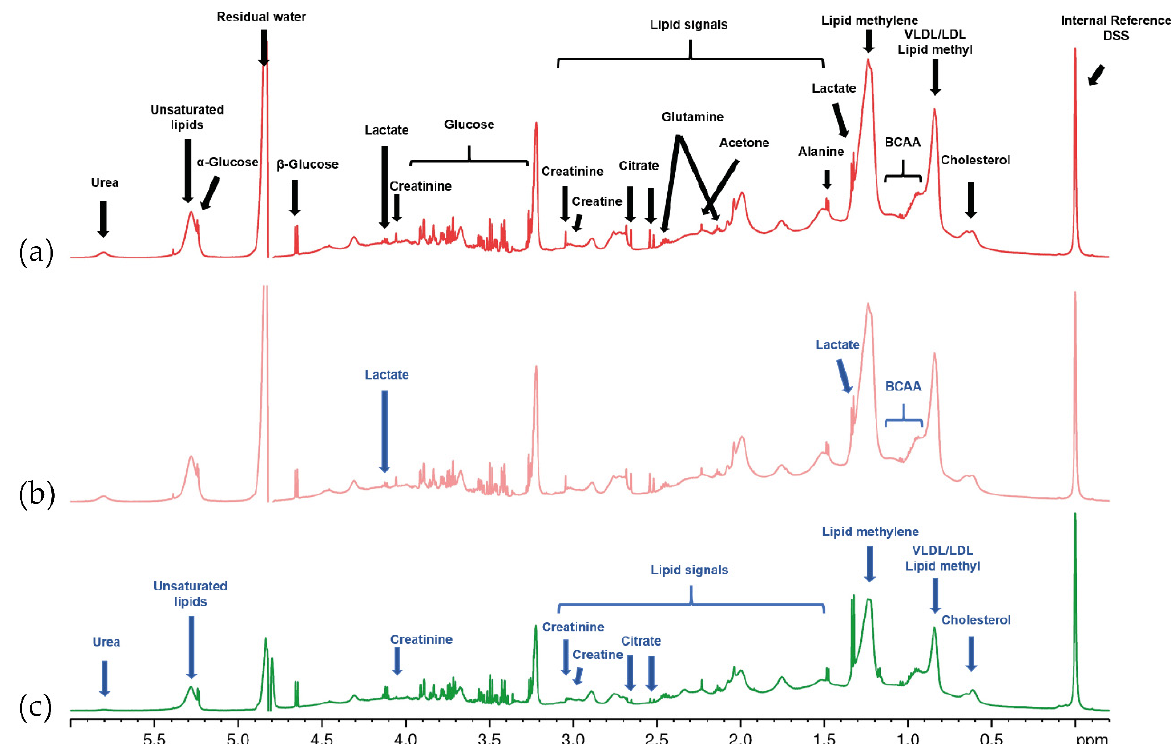
Figure 1. Expansion ( − 0.2–6.0 ppm) of 1D NOESY-presat 1 H NMR spectra (600 MHz, 300 K) of the serum of the evaluated groups, indicating the main detected metabolites on the different samples. ( a ) Spectrum of the serum of CKD dogs after being fed a renal diet for 6 months (CKD-T6) highlighting all assignments of the metabolites’ NMR signals that have been identified; ( b ) spectrum of the serum of CKD dogs before being fed a renal diet for 6 months (CKD-T0), showing lactate and BCAAs in lower concentrations; ( c ) spectrum of the serum of healthy dogs (CG), highlighting the metabolites with a lower concentration than in both CKD groups (CKD-T0 and CKD-T6). Table 1. Diet composition a as fed and per 1000 kcal and ingredients * according to the manufacturer of the renal diet used in the